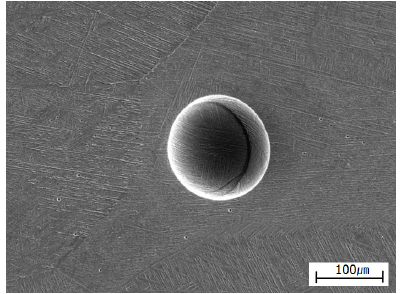
Figure 7. SEM image of pores ( ≥ 100 μ m ) in weld metal (WO).